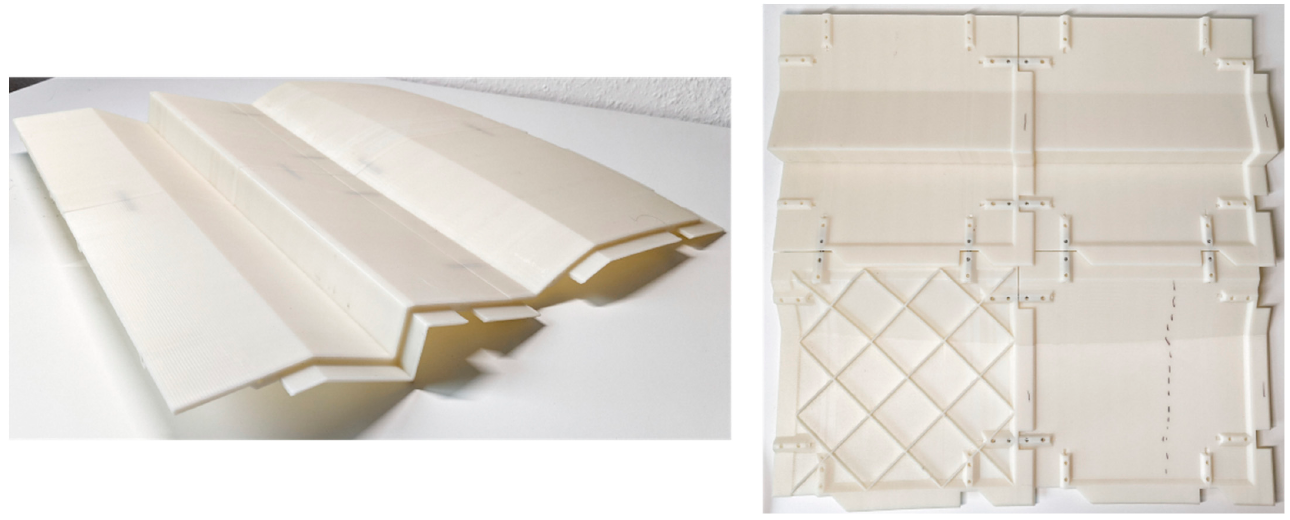
Figure 20. Final assembly of the example.